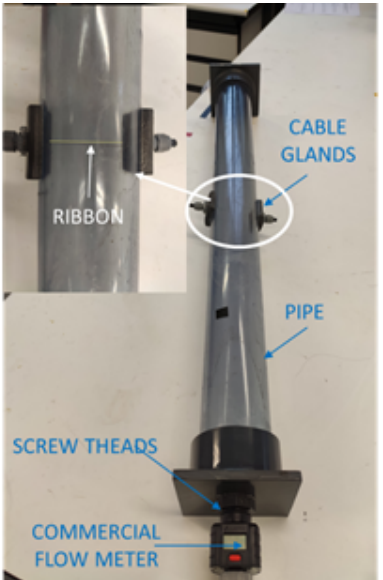
Figure 2. Experimental set-up for the development of water flow meter. The pipe, connections, and Figure 2 . Experimental set-up for the development of water flow meter. The pipe, position of the ribbon are shown. connections, and position of the ribbon are shown.